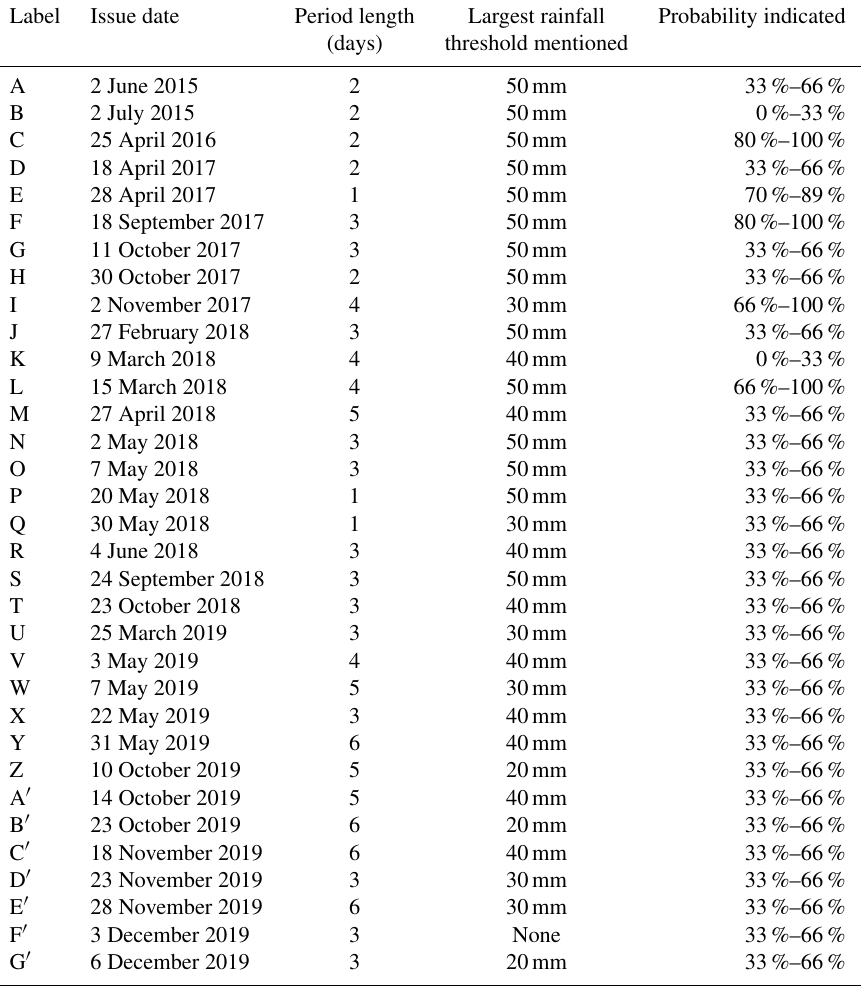
Table 1. Summary of all advisories 2015–2019 evaluated in this study.